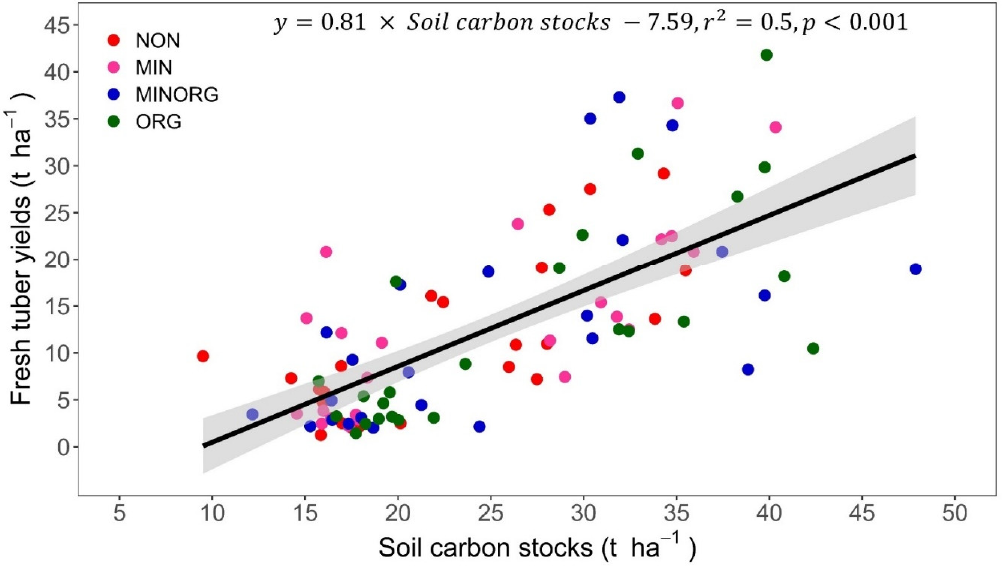
Figure 5. Relationship between soil carbon stocks and fresh tuber yields of water yam measured in 2016 and 2018 in Liliyo and Tiéningboué (Côte d’Ivoire), and Midebdo and Léo (Burkina Faso), under various fertilization regimes. In 2018, yam variety C18 was cultivated in the four sites after either a cereal, a legume, or a yam for each fertilization regime. The linear regression, the coefficient of determination, and the p-values are shown on the graph. For the fresh tuber yields and soil carbon stocks, each point represents a mean of 4 replicates. The grey band indicates the 95% confidence interval. The fertilization regimes are: NON (no fertilization), MIN (sole mineral fertilization as NPK), MINORG combined organic and mineral fertilization), and ORG (sole organic fertilization as